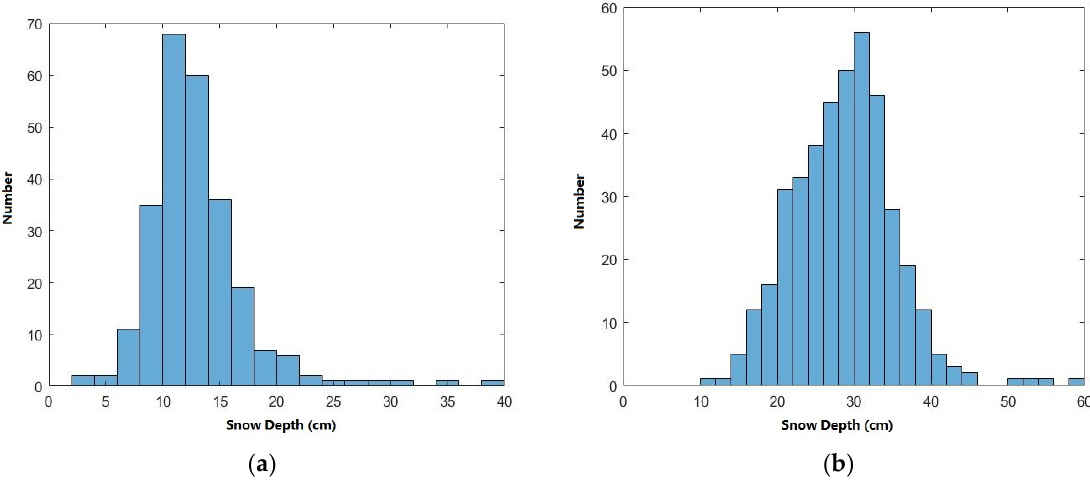
Figure 8. Histogram of snow depths for algorithm calibration. ( a ) FYI; ( b ) MYI. On FYI, the average snow depth of the algorithm development is 12.98 cm, and the Std is 4.54 cm; for the calibration dataset, the average snow depth is 12.91 cm, and the Std is 4.39 cm. Meanwhile, on MYI, the average value of the algorithm development data is 28.75 cm, and the Std is 6.64 cm; for the calibration dataset, the corresponding values are 28.69 cm and 6.56 cm. The locations of OIB data in 2012 and 2013 are shown in Figure